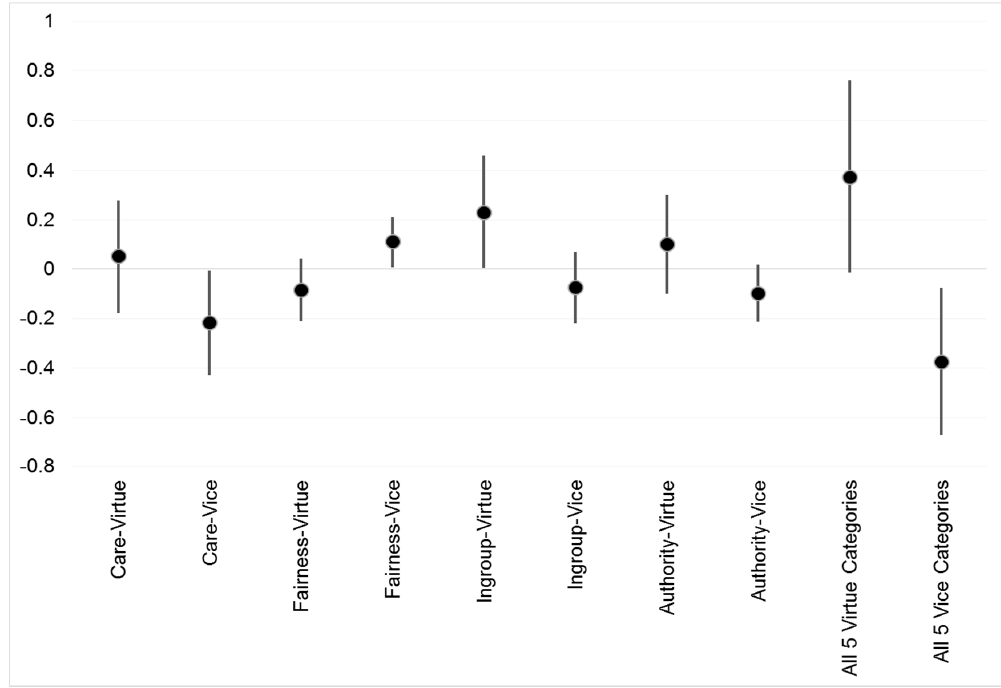
Figure 3. The estimated marginal effect of a Democratic speaker (relative to non-Trump Republican candidates) on the number of moral-foundations words used per segment. Dot represents point estimate and bar represents 95% confidence interval. The All 5 Virtue and All 5 Vice categories sum together the counts for all five moral foundations, including Purity.